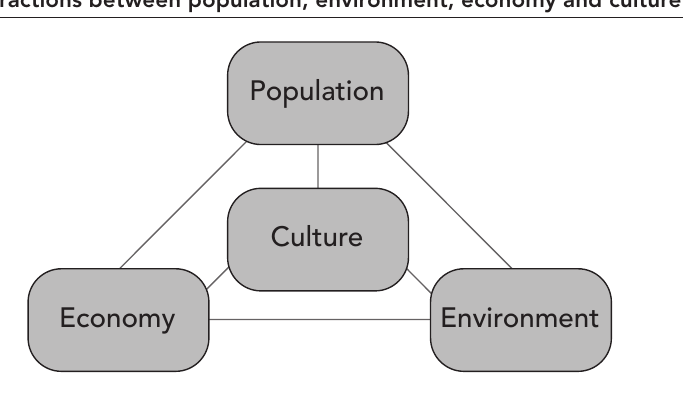
Figure 1. Joel E. Cohen’s (2010) tetrahedron conceptualising the interactions between population, environment, economy and